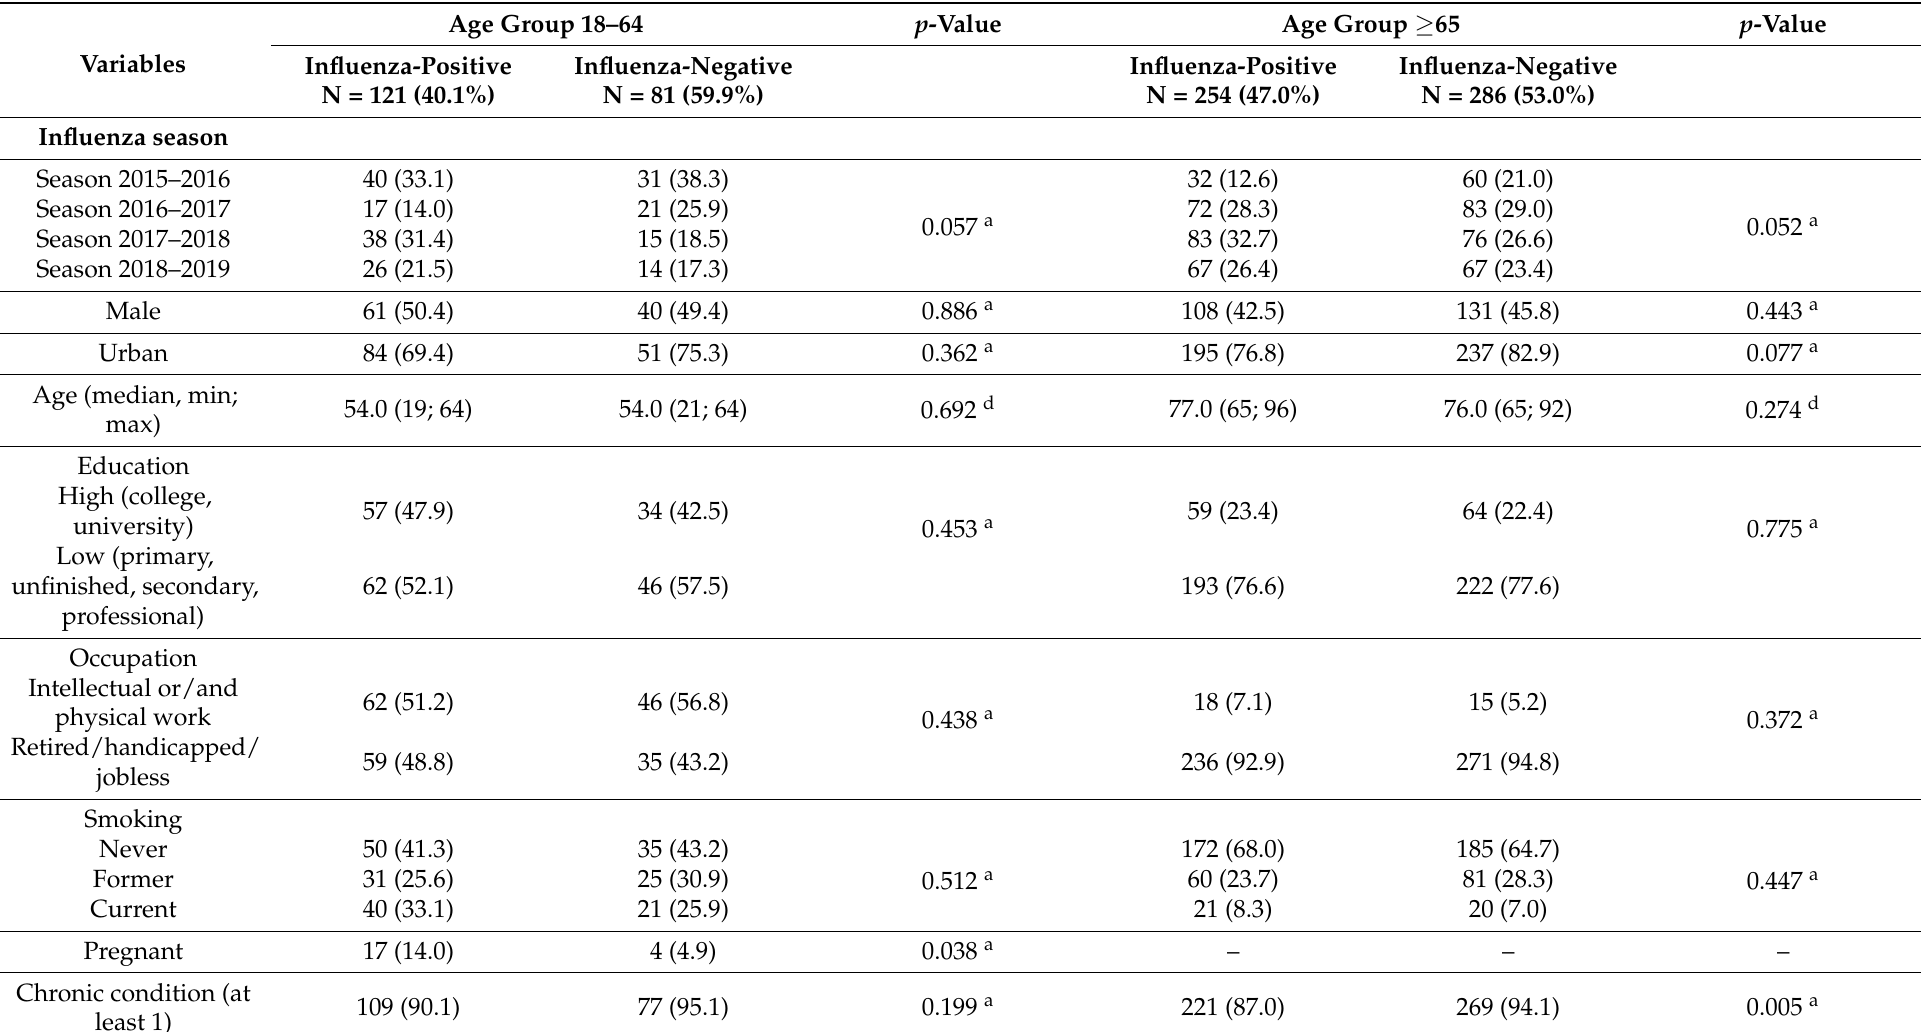
Table 3. Demographic and clinical features of influenza cases and controls and by age-group in the total sample during the 2015–2019 influenza